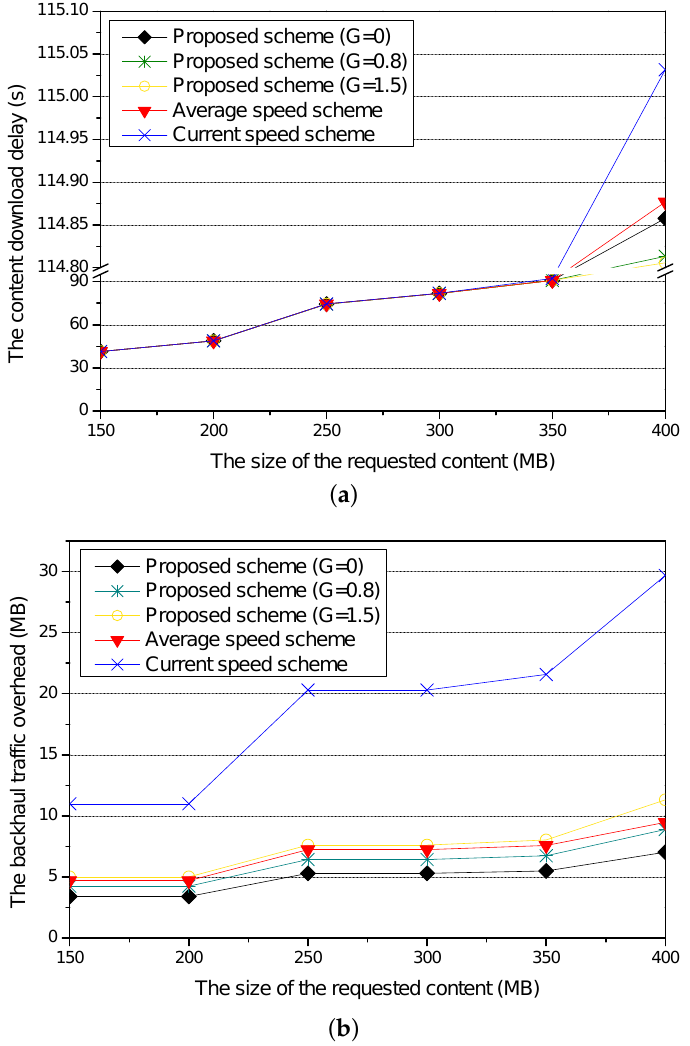
Figure 12. Simulation results for different sizes of the requested content: ( a ) the content download delay and ( b ) the backhaul traffic